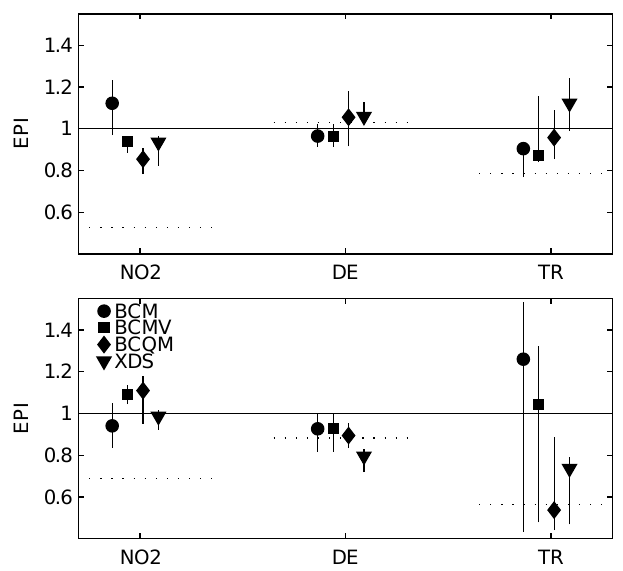
Figure 7. EPI for each BC method for NO2, DE, and TR for win- ter (top) and summer (bottom). The markers indicate the median and the lines represent the range covered by the 25th and 75th per- centiles. All the results are for the 1-year level and temporal ag- gregation of 1 day. Note the different scales used in the y axis for winter and for